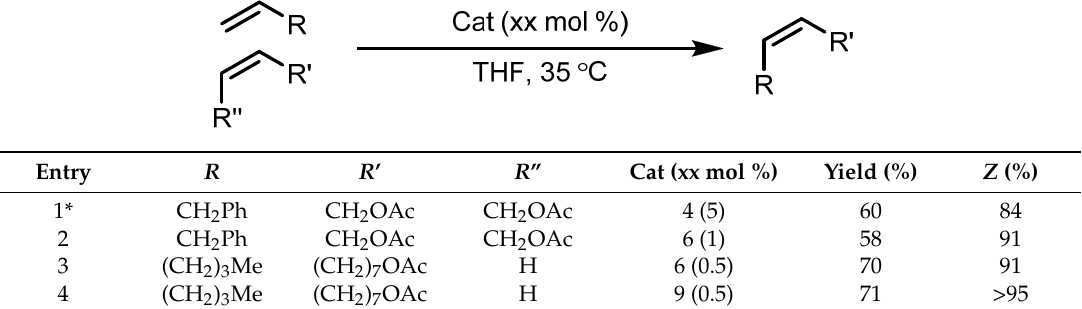
Table 2. Comparison of cyclometalated catalysts using cross metathesis (CM).